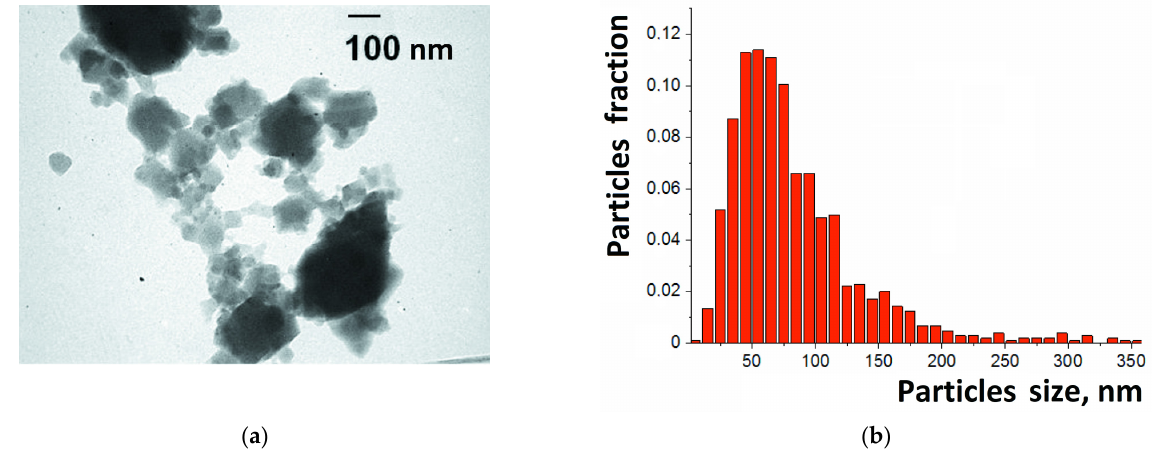
Figure 2. TEM image ( a ) and particle size distribution ( b ) for HKUST-1 used in this study. The porosity of HKUST-1 was characterized via measurements of the nitrogen ad(de)sorption isotherm (Figure 3). The BET specific surface area was S BET = 1435 cm 2 /g, and the micropore volume calculated using Dubinin–Radushkevich model was V DR = 0.61 cm 3 /g. This value, as well as the entire shape of the isotherm, were consistent with the value of S BET was closer to the higher boundary of the range of the specific surface areas reported for HKUST-1 prepared by different methods). The obtained HKUST-1, with an average particle of size 40–60 nm, was used for the experiments on catalytic benzoin oxidation.